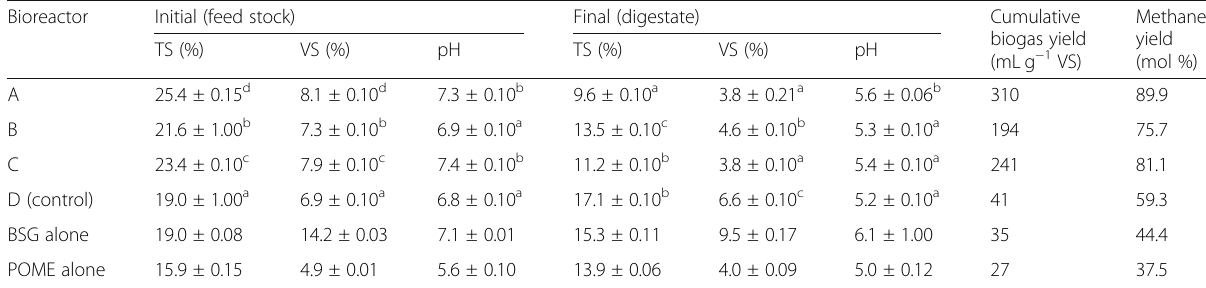
Table 1 Physicochemical characteristics of experimental mixtures Bioreactor Initial (feed